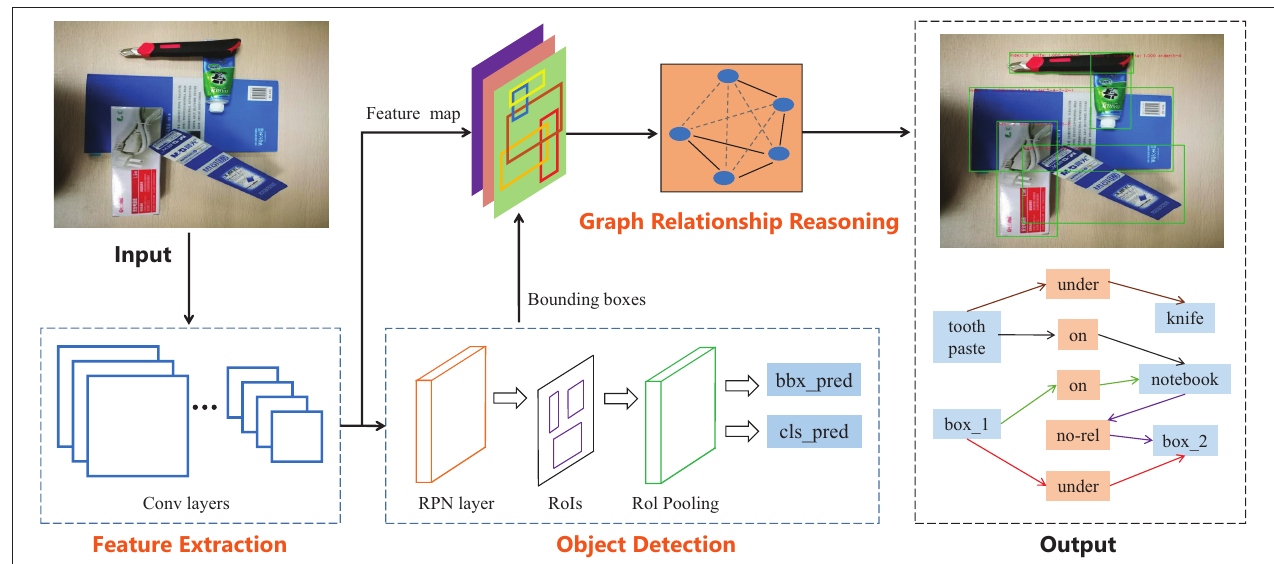
FIGURE 2 | Overview of our end-to-end object relationship reasoning architecture. The model mainly includes three modules: feature extraction, object detection and graph relationship reasoning. The feature extraction module consists of a stack of convolution layers (VGG or ResNet) that output feature maps. The object detection module is used to generate the bounding boxes of all objects. The feature maps and the bounding boxes are used to predict the object relationships and the manipulation order through the graph relationship reasoning